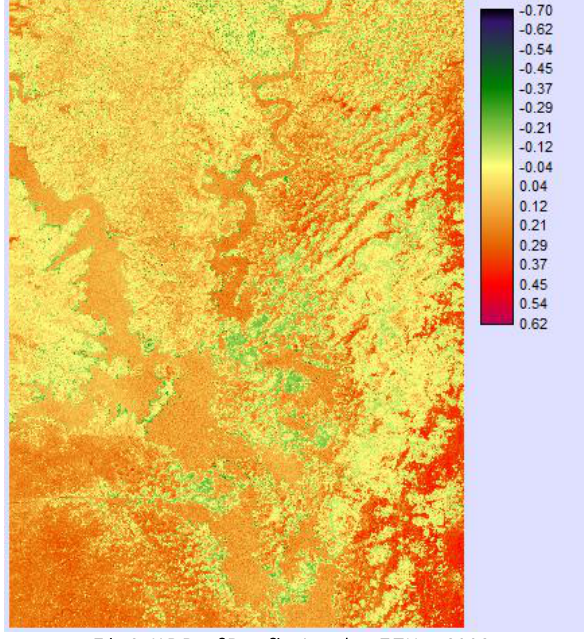
Fig.3: NBR of Pre-fire Landsat ETM+ 2002 Figs.3 and 4 show the NBR images of 2002 and 2003. In pre- fire images, vegetated areas have values greater than zero and areas of bare ground or rock have values less than zero (Miller and Yool, 2002). However, in fig.3 much of the greens which are associated with negative values are cloud cover. The real NBR values ranges from 0.04 to 0.62. In post-fire images, increasing fire severity is associated with decreasing values (Miller and Yool, 2002). As shown in Fig.4, except at the eastern corridor from Dambai to Pui Katanga fire severity is intense within the locality with intensity increasing from -0.02 to -0.78. Negative values of dNBR indicate a positive vegetation response (growth) and positive values indicate a negative vegetation response (mortality) (Eidenshink et al,